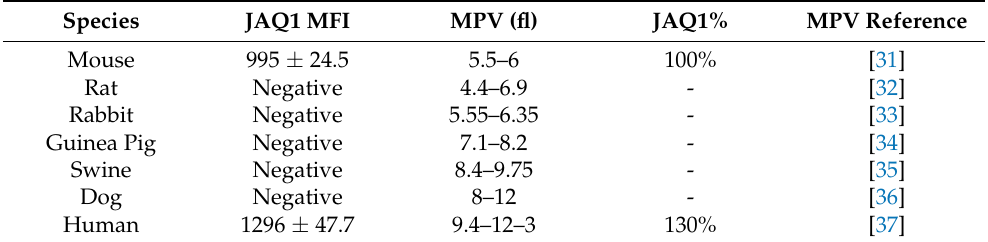
Table 1. Flow cytometric analysis of JAQ1 binding to the platelet surface of different species. The data are reported as MFI of JAQ1-FITC (JAQ1 MFI) and as percentages with respect to mouse MFI (JAQ1%). Mean Platelet Volume (MPV) of the different species are reported in femtoliter (MPV). “Negative” indicates MFI values comparable to isotype IgG-FITC control values. Data are reported as mean ± SD. Species JAQ1 MFI MPV (fl) JAQ1% MPV